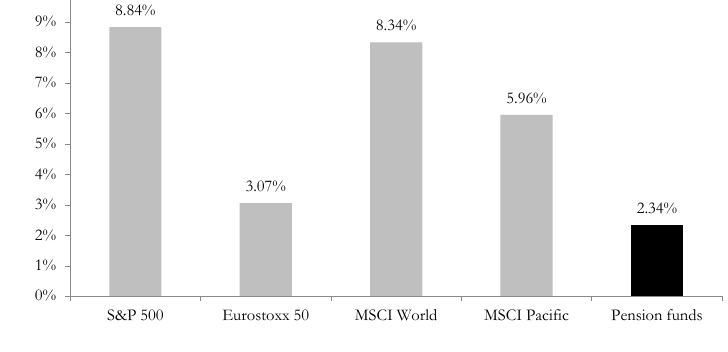
Fig. 1 – The average annual yield of the selected market indices and the aggregate value of the pension funds from 2005 to 2015. Source: The Organisation for Economic Co-operation and Development data The first model equation is as follows: PF= 26.8545+0.257954 SP-0.17554 ES+0.61093 MSP+0.113586